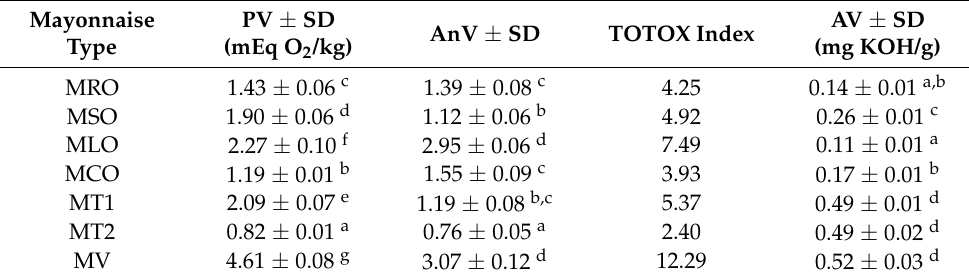
Table 5. Oxidation parameters of mayonnaises.